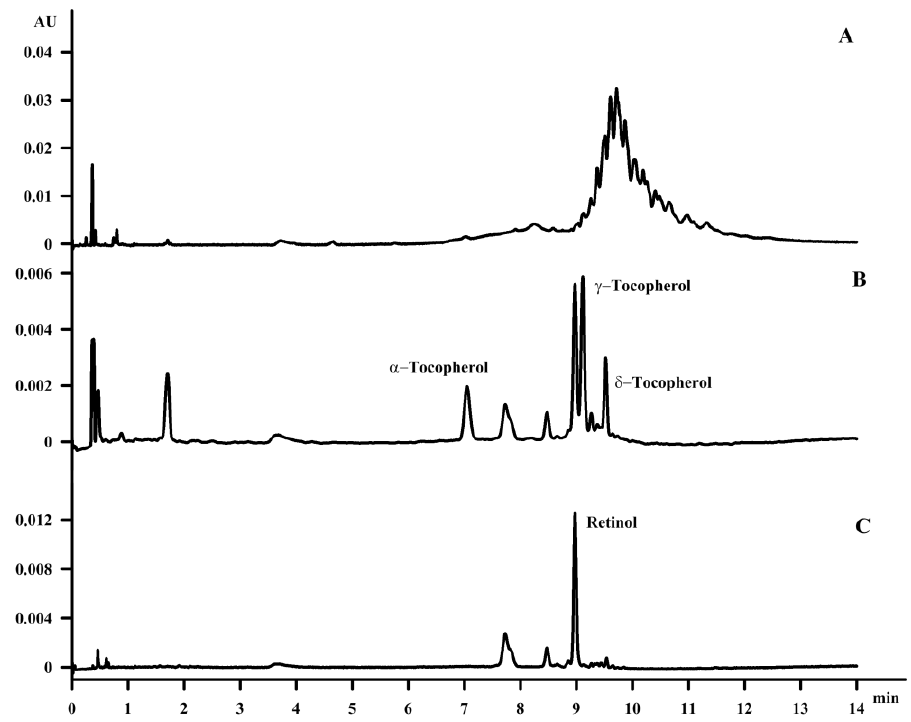
Figure 6. The chromatogram of fish oil, before purification ( A ), after purification ( B -220 nm), after purification ( C -320 nm). Table 4. Content of fat-soluble vitamins in the hemp seed oil and waste fish oil before and after the saponification